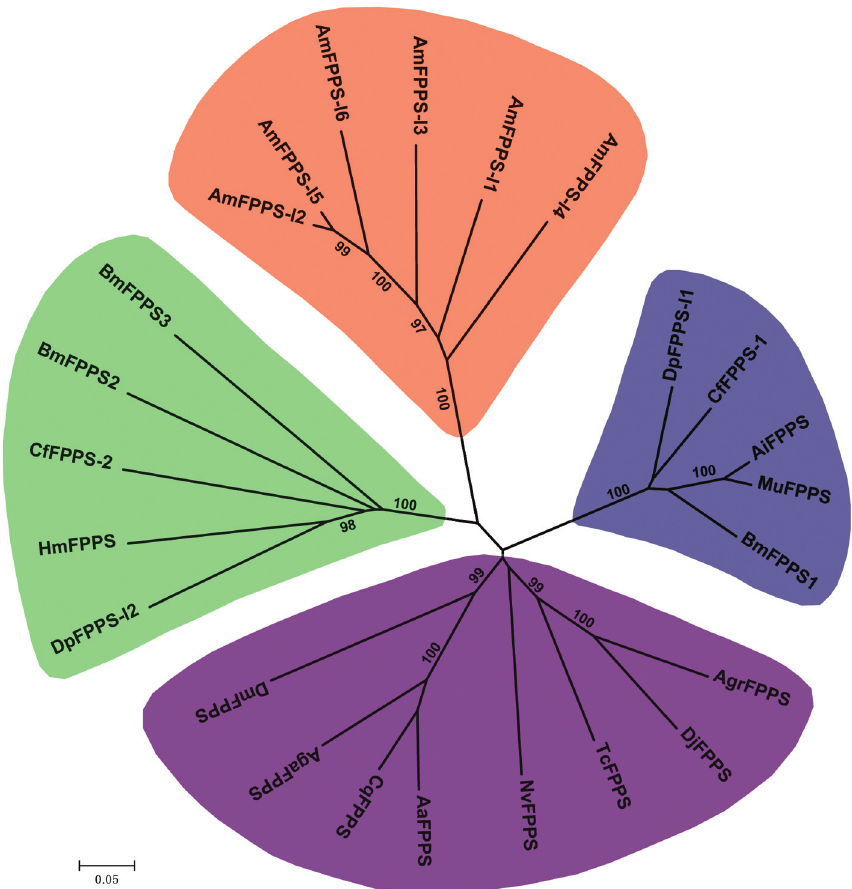
Figure 2 - Phylogenetic tree of the FPPS genes from B. mori and other insects. Based on the multiple alignments of the amino acid sequences of FPPS proteins from B. mori and other insects, a phylogenetic tree was constructed using the neighbor-joining method with 1000bootstrap replicates after re- moving the highly divergent sequences at the N- or C-terminus. Bootstrap values > 60% are marked. Bm, Bombyx mori ; Dm, Drosophila melanogaster ; Aga, Anopheles gambiae ; Am, Apis mellifera ; Tc, Tribolium castaneum ; Dp, Danaus plexippus ; Cf, Choristoneura fumiferana ; Hm, Heliconius melpomene ; Mu, Mythimna unipuncta ; Agi, Agrotis ipsilon ; Aa, Aedes aegypti ; Cq, Culex quinquefasciatus ; Agr, Anthonomus grandis ; Dj, Dendroctonus jeffreyi ; Nv, Nasonia vitripennis